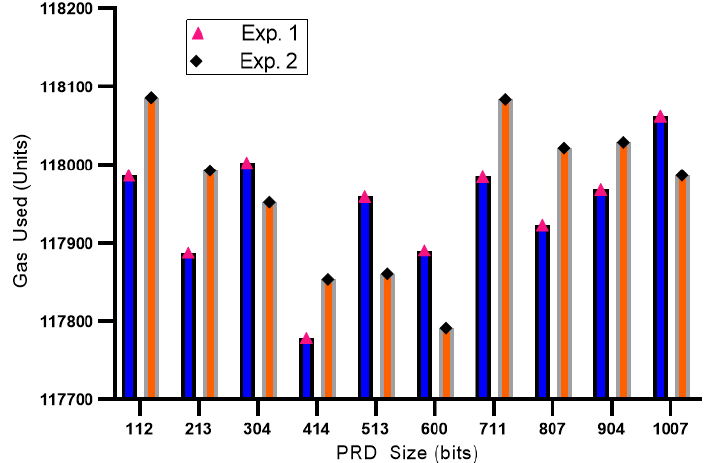
Figure 10. The information on gas usage by RSU in distributing Ether for V PKn .